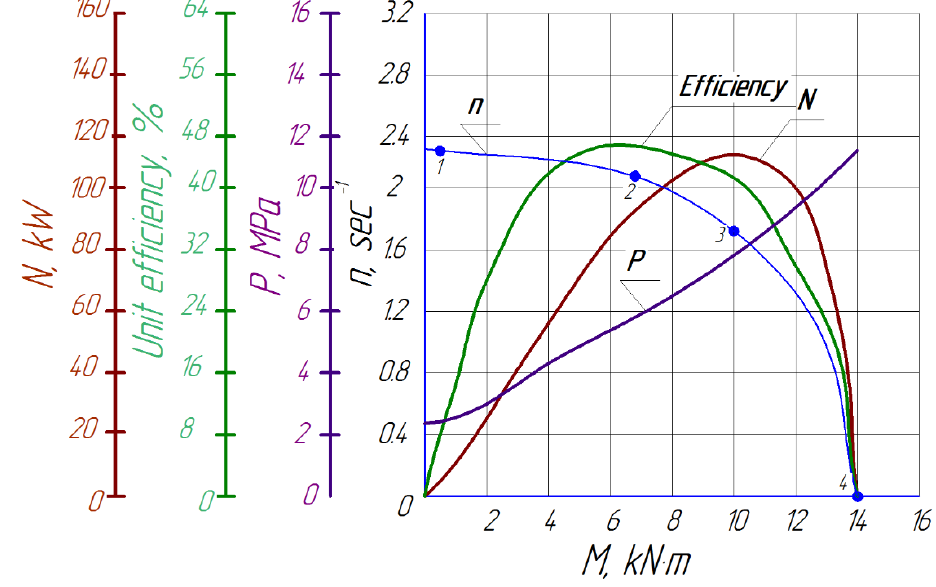
Figure 6. Typical characteristics and points of characteristic modes of small-sized PDM.